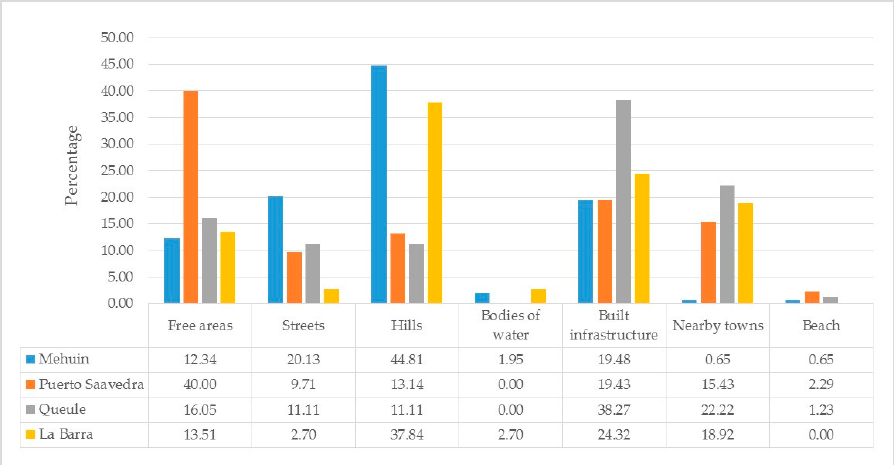
Figure 3. Frequency of mention of site typologies for each town.